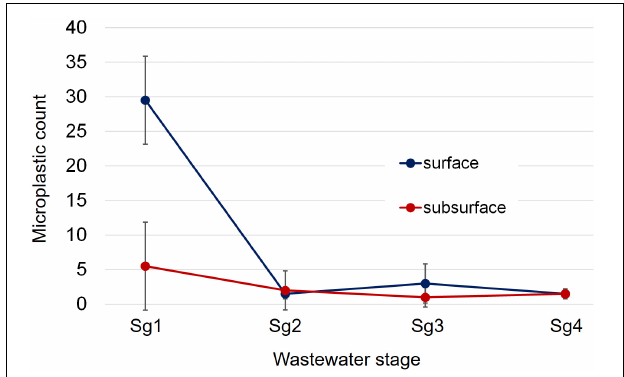
FIGURE 2 | Total microplastic count data across the four wastewater stages sampled in parity with the progress of wastewater treatment from influent to effluent in both surface and subsurface samples. Stage 1 (Sg1) refers to the primary settlement stage, Stage 2 (Sg2) to the activated biological anoxic stage, Stage 3 (Sg3) to the activated biological aerobic stage, and Stage 4 (Sg4) to the final effluent. Reported values are mean microplastic counts based on the two sampling visits, with the error bars being one time the standard deviation.